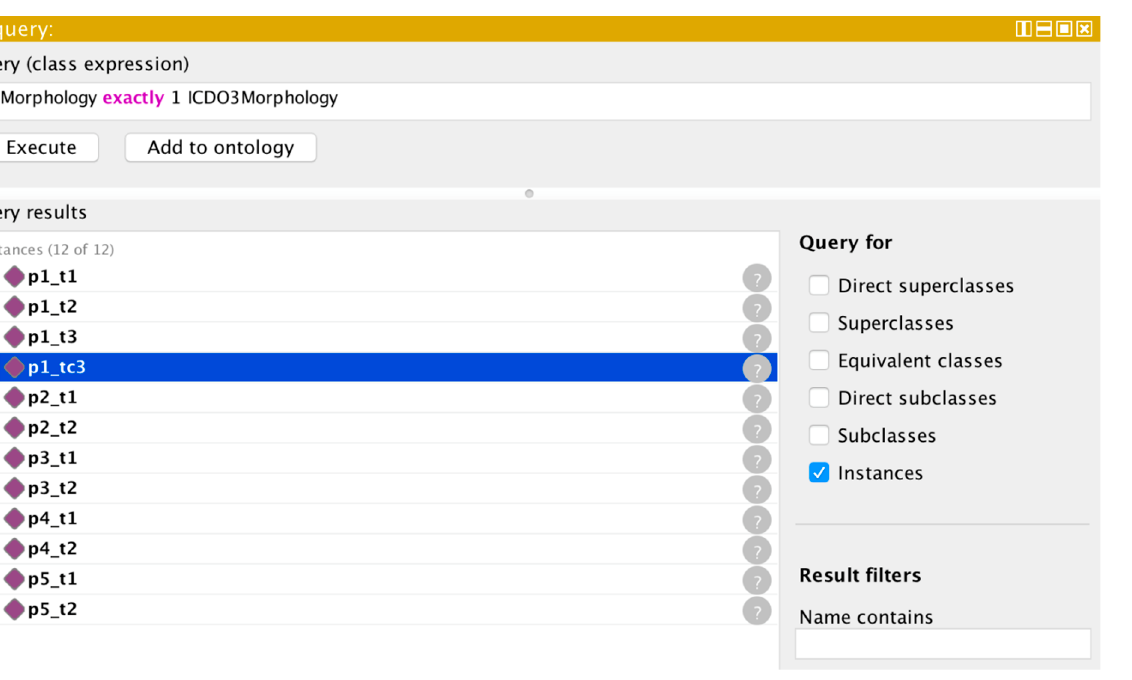
Figure 17. DL query for entities with exactly one morphology code.